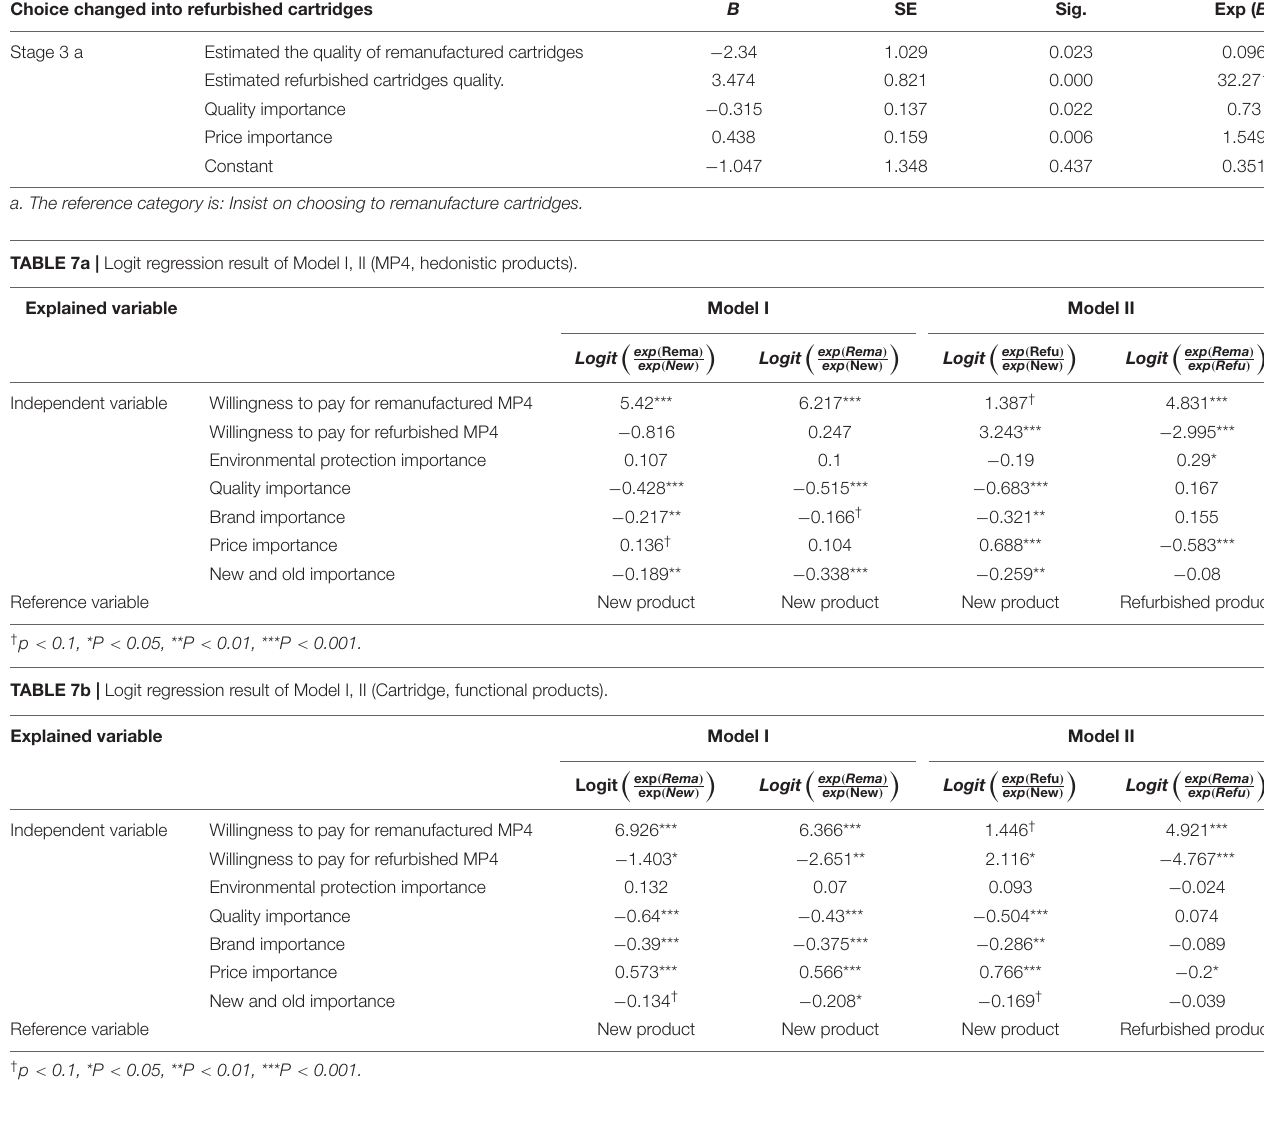
TABLE 6b | L 1 logit Regression Analysis (changes in purchase options for cartridges). Choice changed into refurbished cartridges